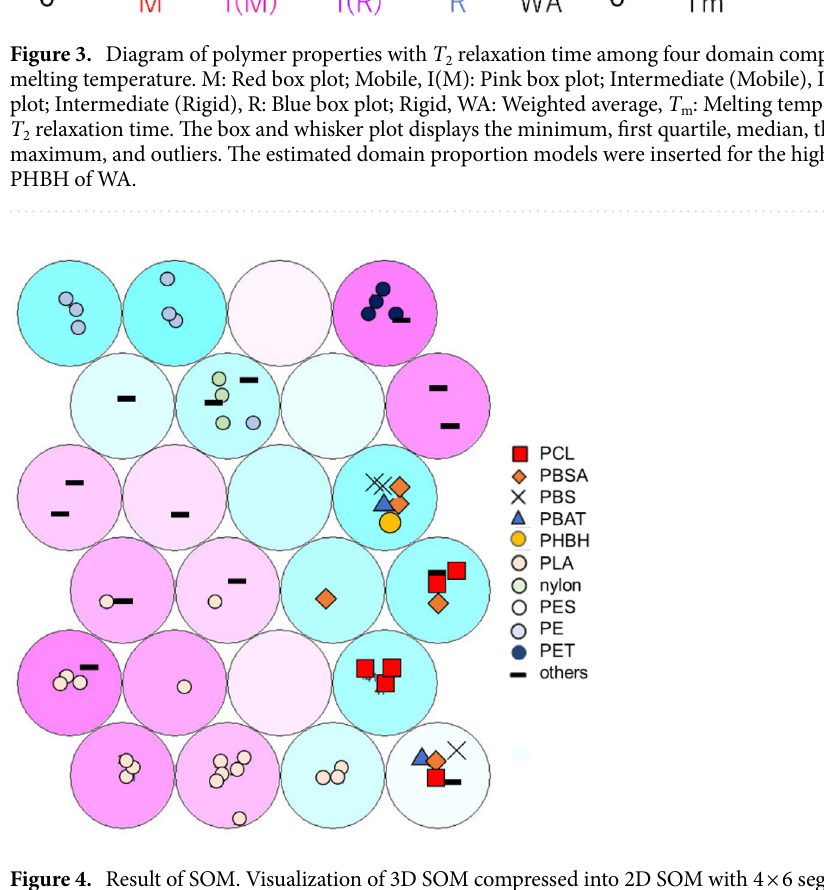
Figure 4. Result of SOM. Visualization of 3D SOM compressed into 2D SOM with 4 × 6 segments, red: positive, blue: negative. red square: PCL, orange: PBSA, black cross: PBS, blue triangle: PBAT, yellow circle: PHBH, light pink: PLA, light green: nylon, white: PES, light blue: PE, navy blue: PET, black bar: other polymers. Polymer numbers in the figure refer to Table